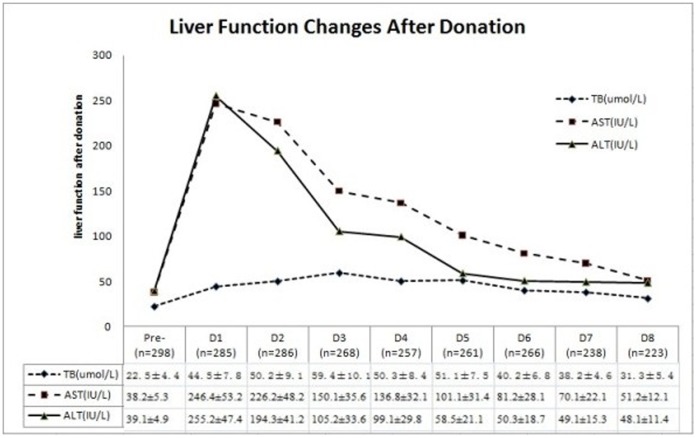
Changes in liver function (total bilirubin, aspartate aminotransferase, alanine aminotransferase) after donation.